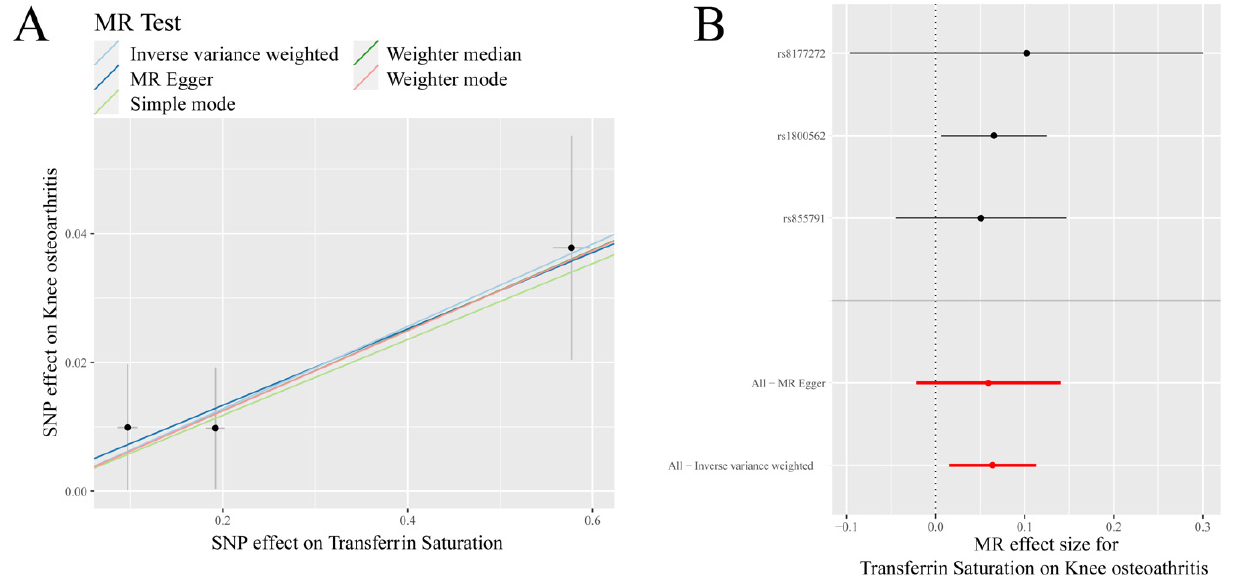
Figure 1. MR results of transferrin saturation and knee osteoarthritis (KOA): ( A ) scatter plot of ge- netic correlations of transferrin saturation and KOA using different MR methods. The slopes of line represent the causal effect of each method, respectivel; ( B ) forest plot of the causal effects of trans- ferrin saturation associated SNPs on KOA. The red and black dot/bar indicate the causal estimate of transferrin saturation level on risk of patients with KOA.